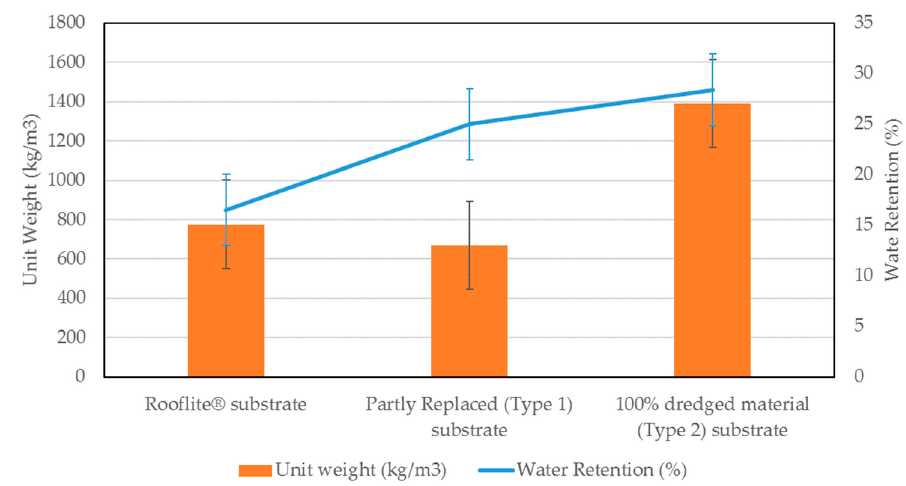
Figure 7. Relationship between water retention capacity and wet unit weight of substrates.